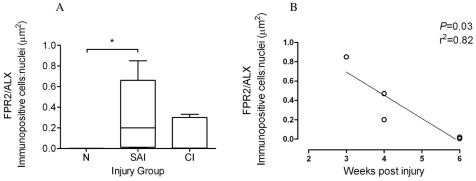
FPR2/ALX expression in normal and injured equine tendons.(A) Box plot illustrating ratio of areas (µm2) of immunopositive cells: counterstained nuclei of expression of the Lipoxin A4 receptor (FPR2/ALX) in normal (N, n = 5), sub-acute (SAI, n = 5) and chronic injured (CI n = 5) equine tendons. Values represent median with maximum and minimum range. * P<0.05. (B) FPR2/ALX expression in sub-acutely injured tendons (n = 5) showing significant decline in FPR2/ALX protein expression with time after injury (P = 0.03, r2 = 0.82).